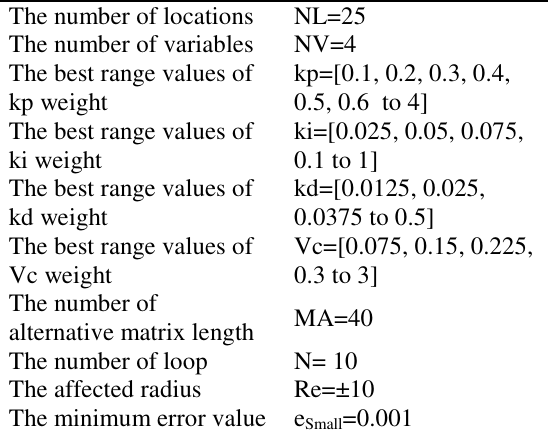
Table 2, The parameters of DEO algorithm. The number of locations